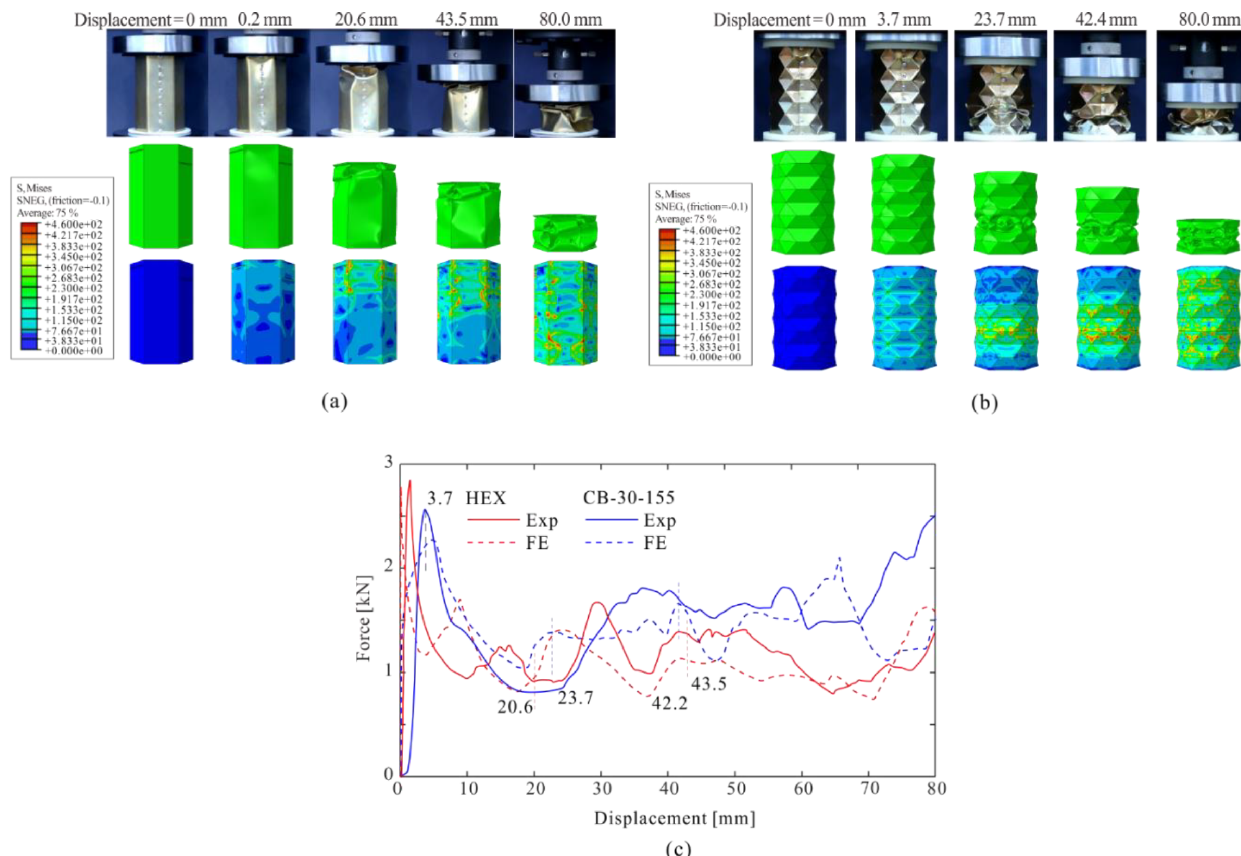
Figure 4. The crushing process of HEX and CB-30-155: (a) the deformation process of HEX; (b) the deformation process of CB-30-155; (c) experimental and numerical force versus displacement curves of HEX and